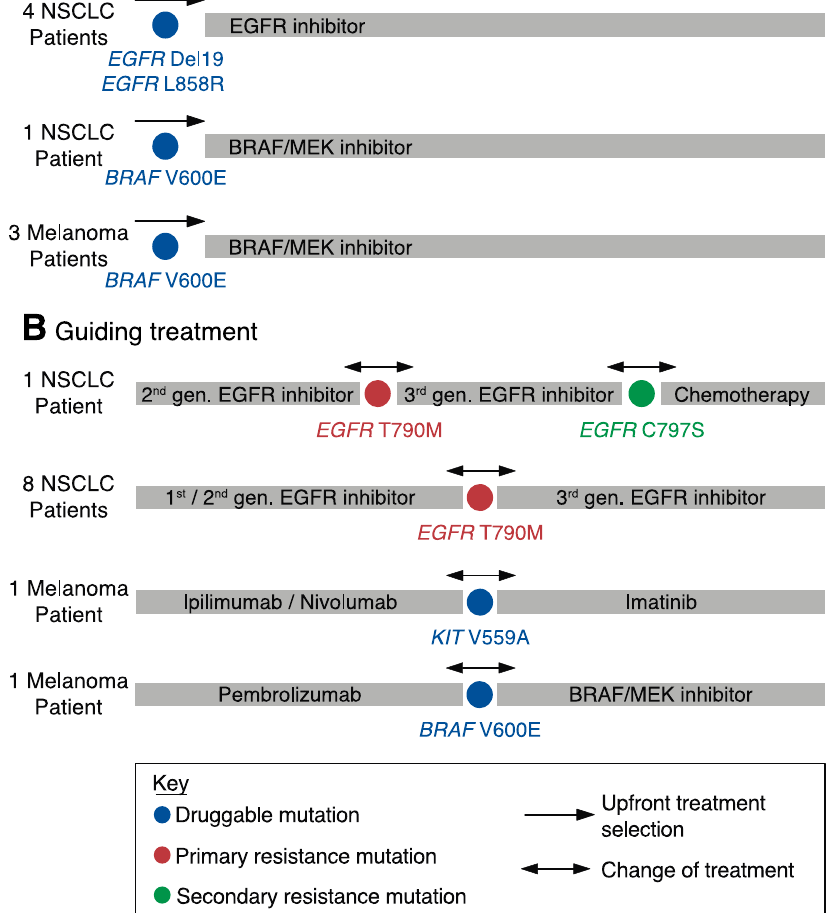
Figure 2. Therapy selection reflected by ctDNA profiling. ( A ) Patient data demonstrating upfront treatment selection in eight patients, which was reflected by the identification of mutations in ctDNA. ( B ) Detection of resistance mutations in blood plasma using ctDNA profiling in 11 patients. Black arrows indicate treatment selection or change of therapy based on mutation detection in actionable gene targets (colored in blue, red, and green). 1st, first; 2nd, second; 3rd, third; gen., generation. NSCLC, non-small cell lung